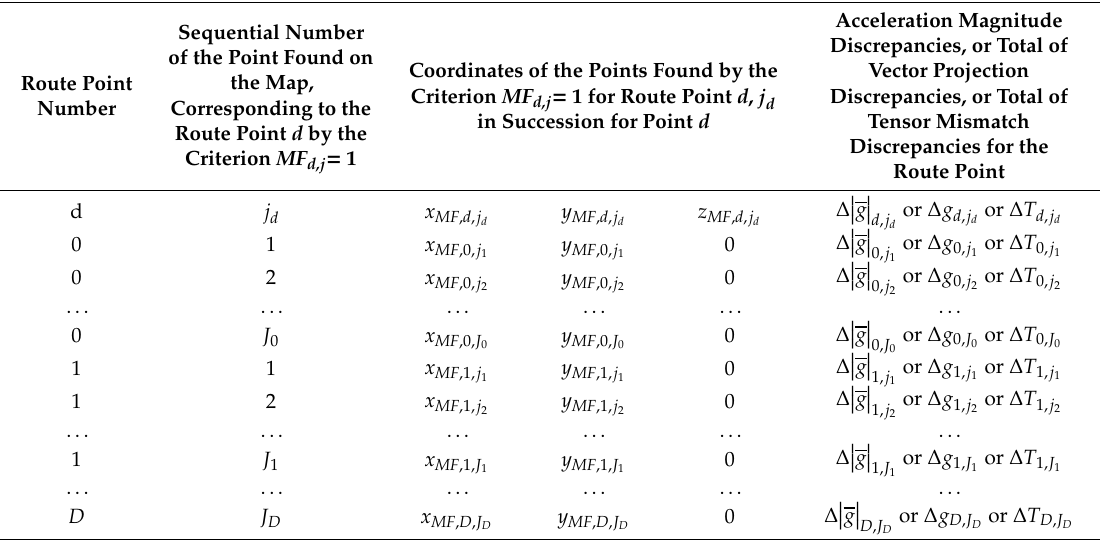
Table 7. Point searching